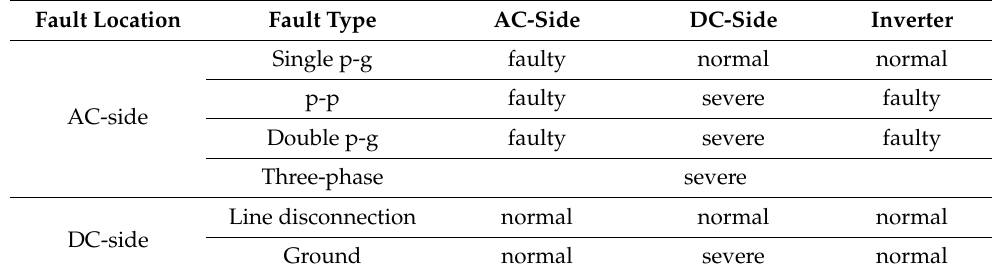
Table 3. Effects of faults on hybrid